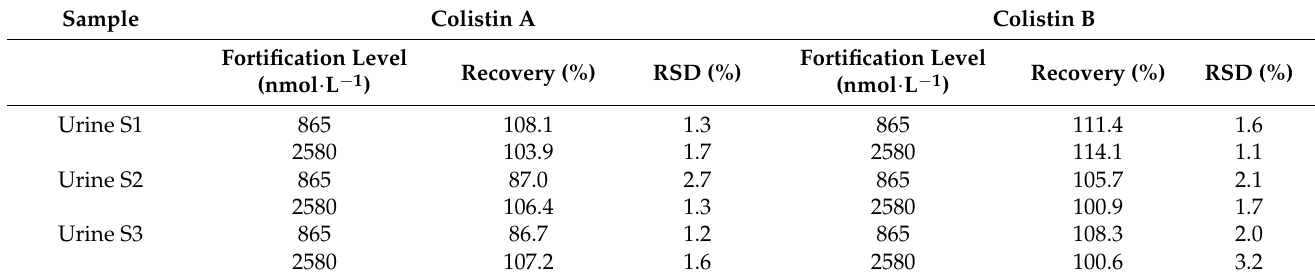
Table 3. Analysis of representative urine samples using the proposed HPLC–PCD